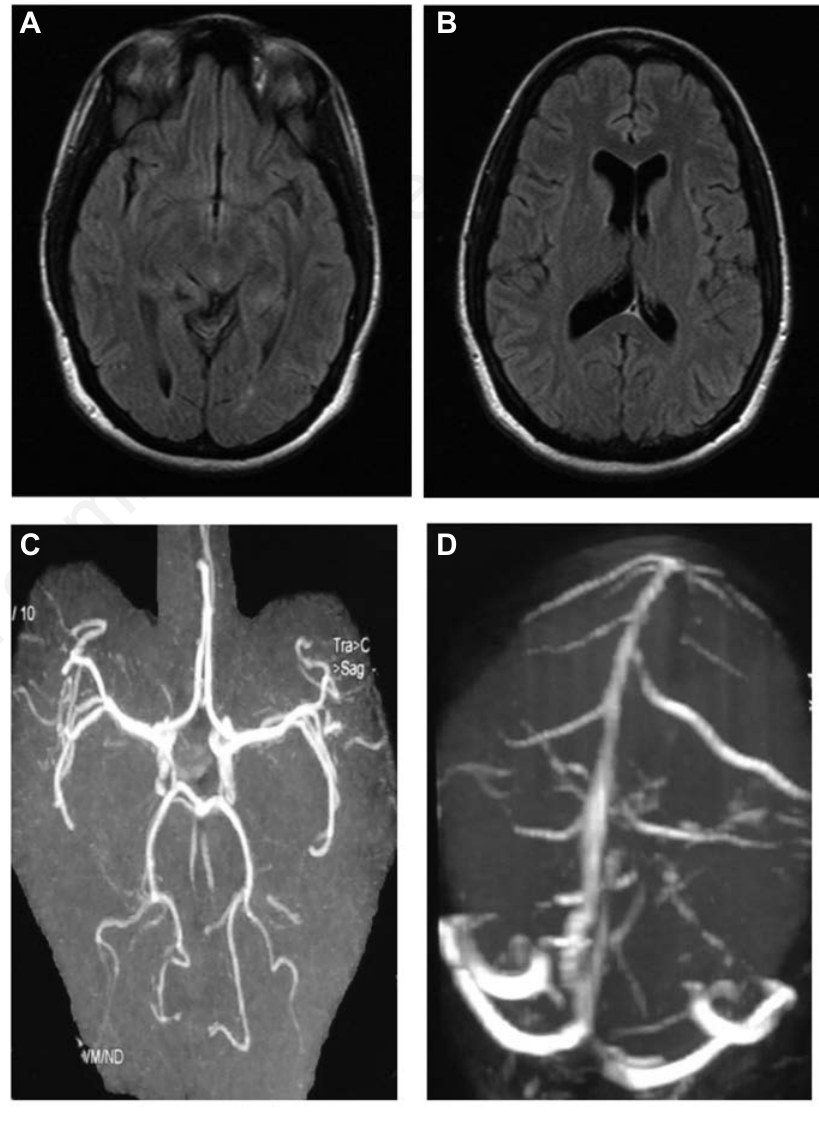
Figure 1. A,B) Axial flair magnetic resonance sequence images of the brain showing nor- mal ventricles without transependymal changes; C) magnetic resonance angiography scan of Circle of Willis arteries and its main branches; D) magnetic resonance venography scan section, demonstrating normal